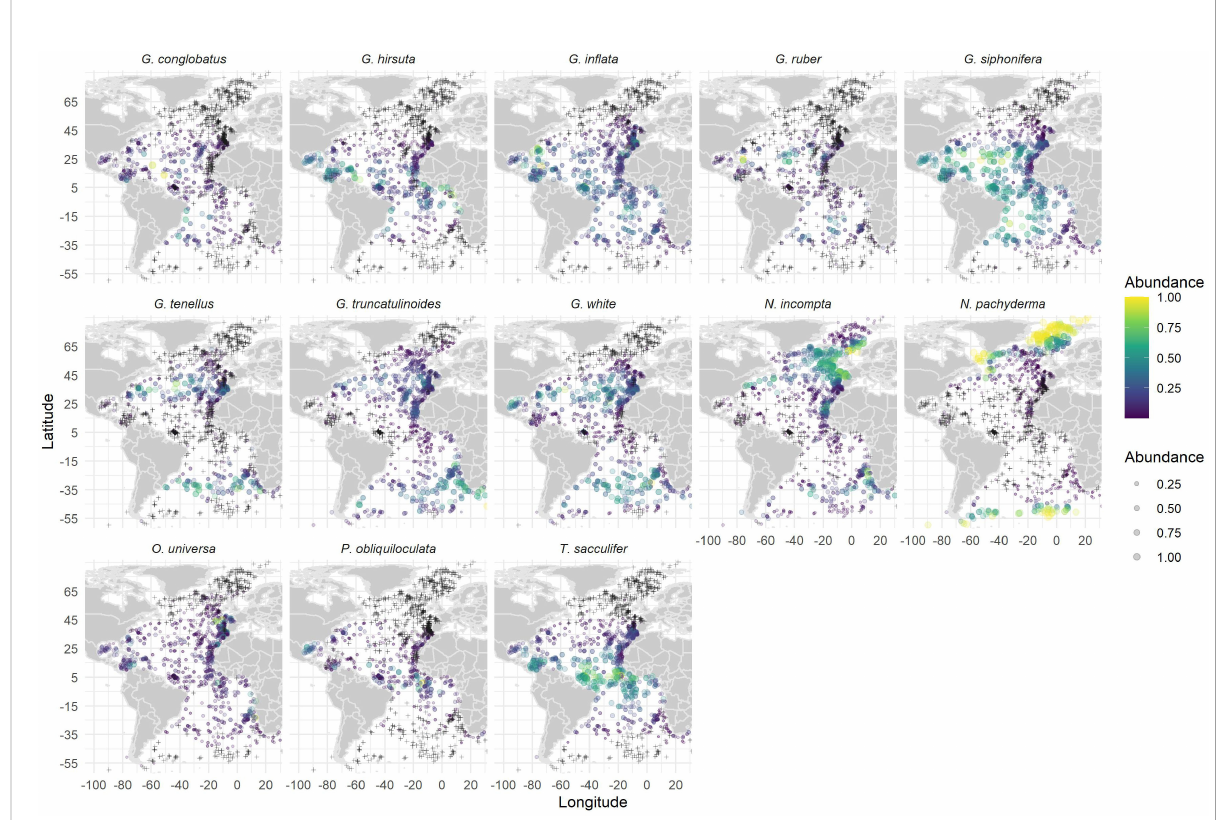
FIGURE 7 Spatial distribution and relative abundance of the 5 species with higher cumulative contribution in all environmental variables (abundance scale in both color and point size; crosses indicate zero